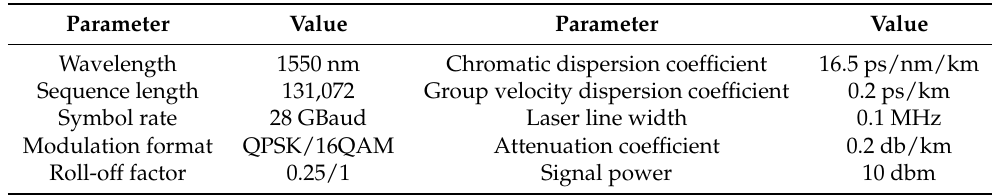
Table 1. System simulation